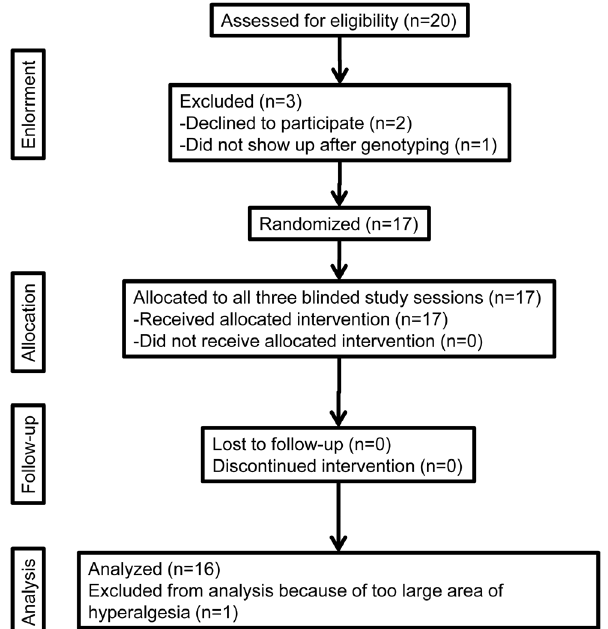
Figure 1. Flowchart of the study.